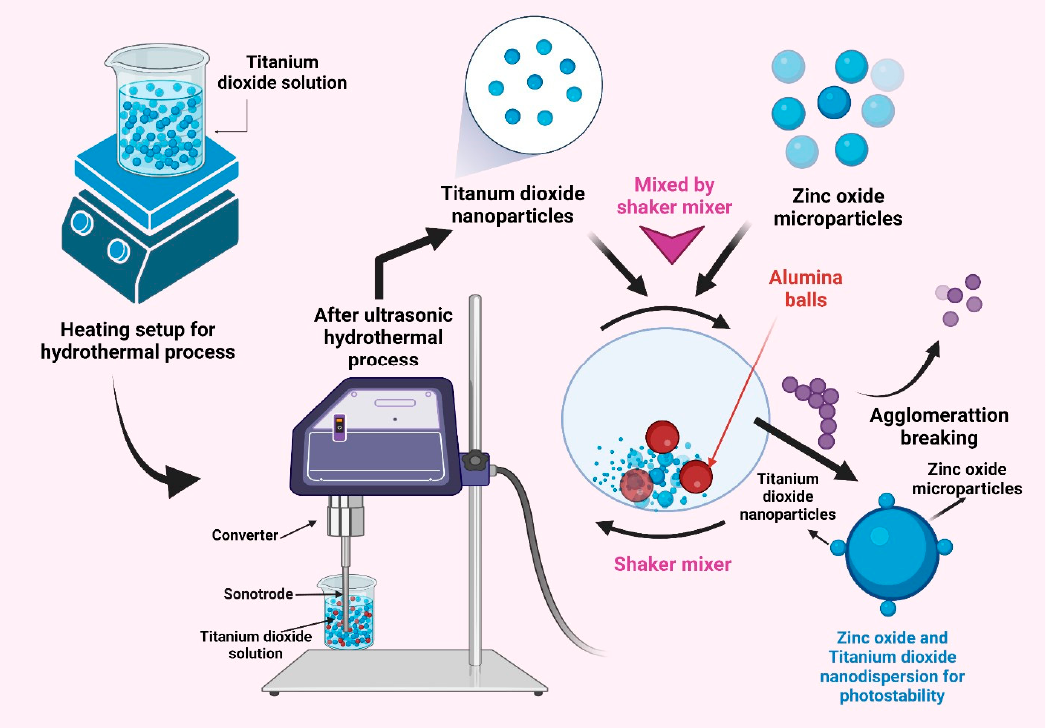
Figure 7. The nanodispersion of titanium dioxide nanoparticles and zinc oxide microparticles is achieved with a shaker mixer by using an alumina ball. Prior to mixing, titanium dioxide nanopar- ticles were prepared by using hydrothermal and ultrasonic treatment. The shaker mixer ensures agglomeration breaking and provides photostable nanodispersions ready for drug